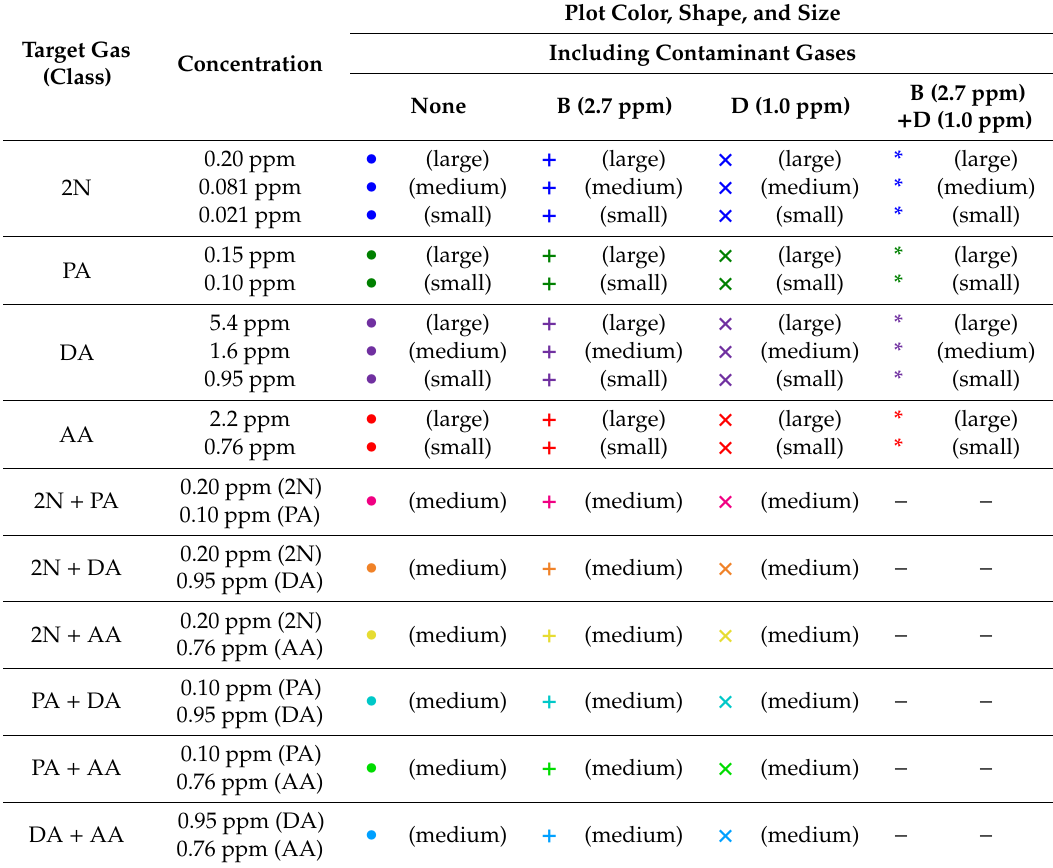
Table 3. Plot shape and size of principal-component-analysis (PCA) and linear-discriminant-analysis (LDA) scores (Figures 5, 7, 9 and